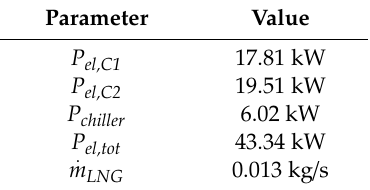
Table 4. Design parameters of the LNG production plant resulting from the optimization analysis.